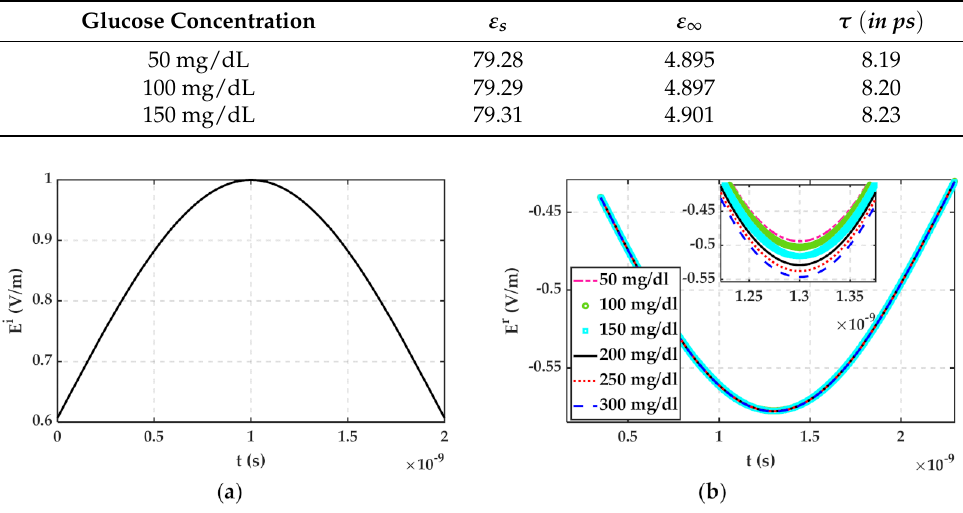
Table 1. Extracted Debye parameter for 23 ◦ C water with the different glucose content.